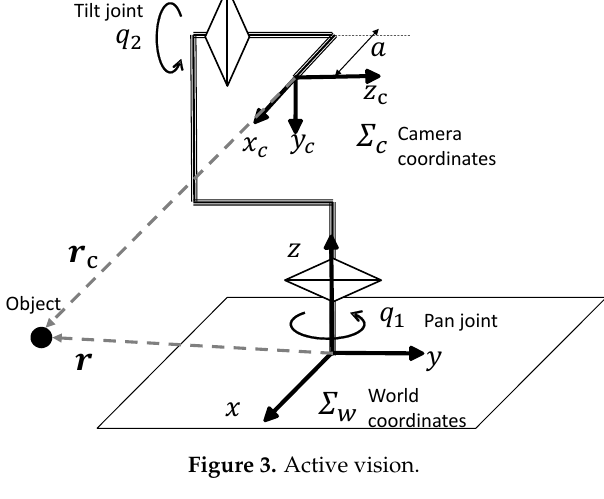
Figure 3. Active vision.